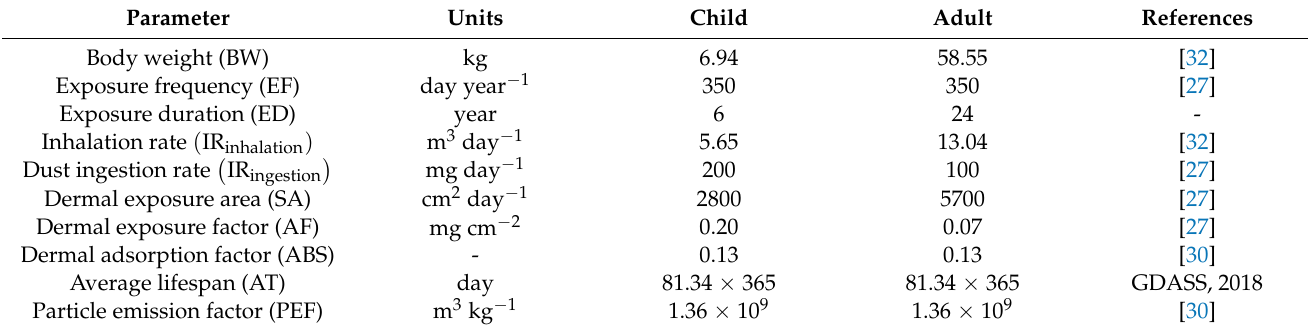
Table 2. Parameters used for lifetime carcinogenic risk assessment